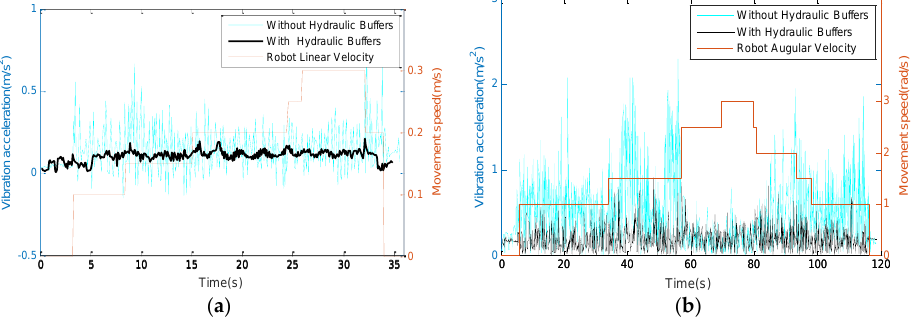
Figure 12. Vibration curves under different moving modes. ( a ) Longitudinal movement; ( b ) rotational movement.